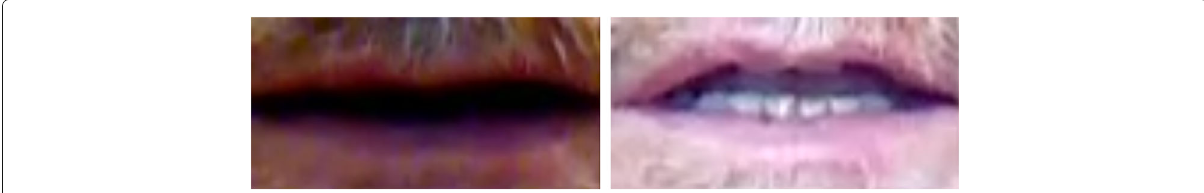
Fig. 6 qFace—Jack. Sample frame from two 20-digit videos in which the XM2VTS sequence was spoken. Video on the left represents the majority of Jack’s data, while the sample on the right was from 1 of the 2 problematic videos for Jack